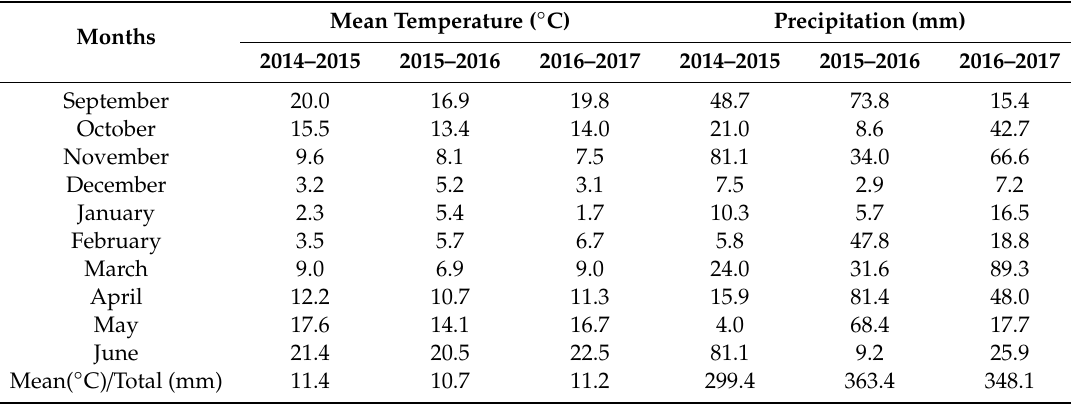
Table 1. Monthly temperature and precipitation during the three growing seasons.